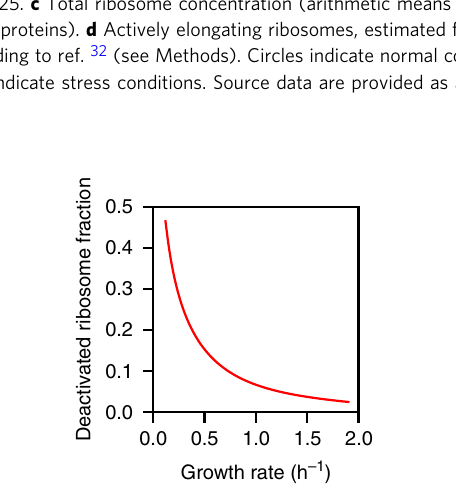
Fig. 4 Estimated fraction of deactivated ribosomes. The deactivated fraction reaches almost 50% for the lowest growth rate assayed in ref. 28 and drops rapidly towards zero at higher growth rates. Source data are provided as a Source Data fi le.